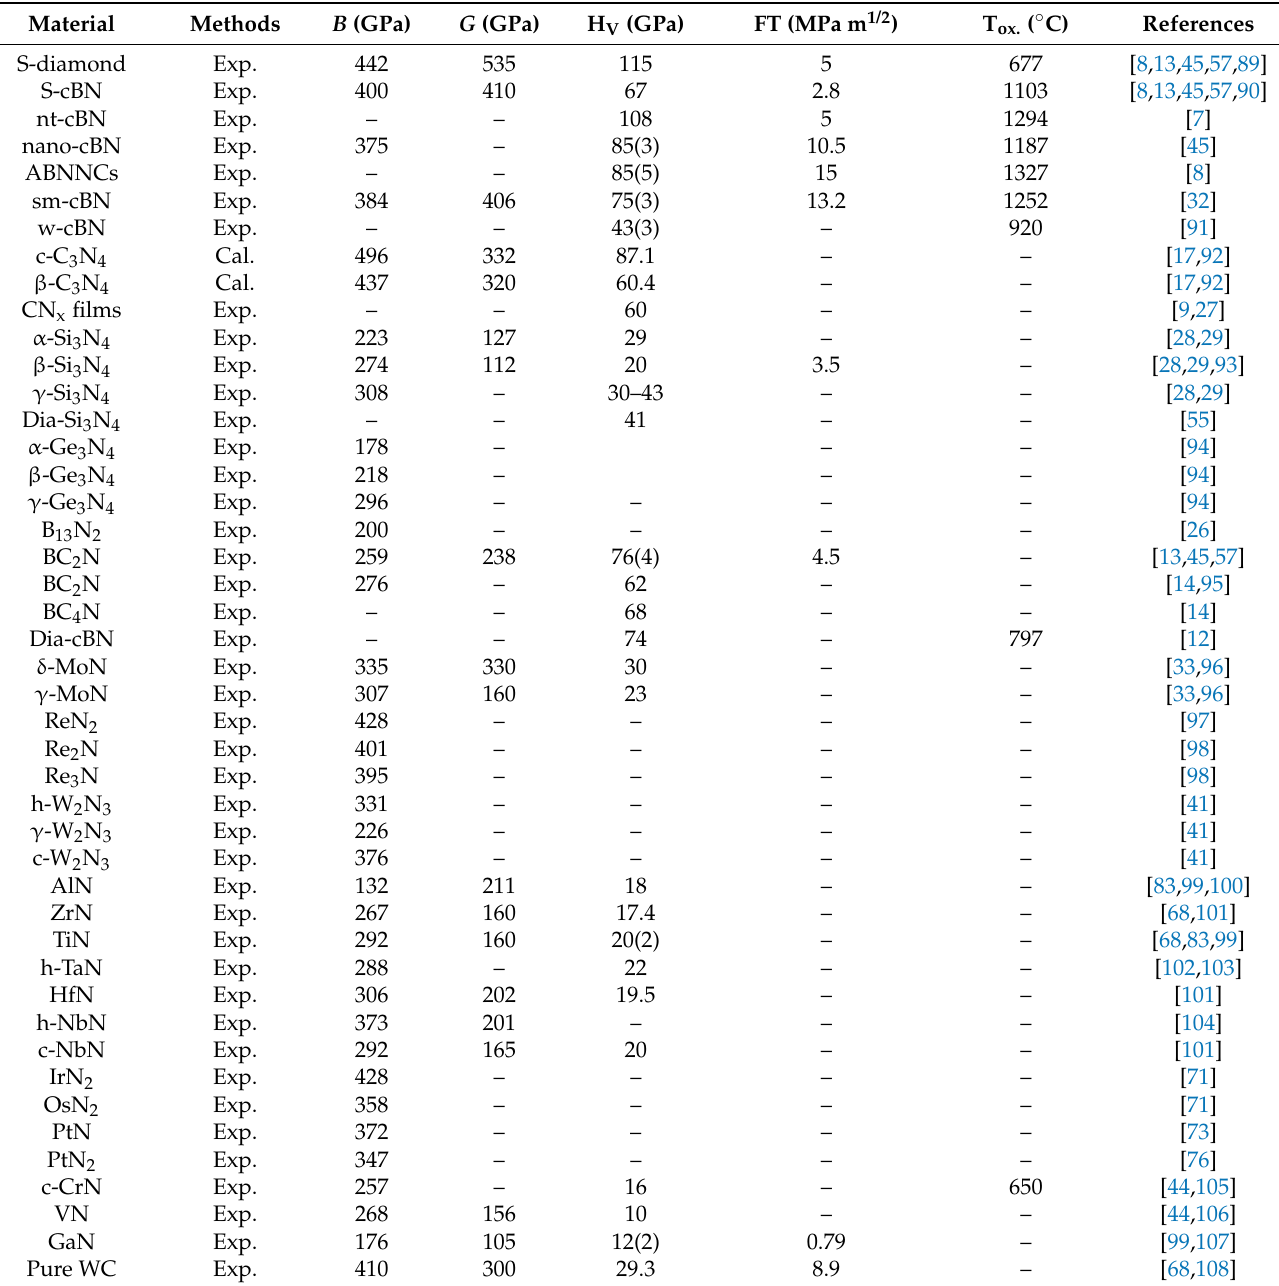
Table 1. Elastic properties, hardness, fracture toughness (FT), and thermal stability of diamond, tungsten carbide (WC), and hard or superhard nitride materials: bulk modulus B, shear modulus G, ABBNs (aggregated boron nitride nanocomposites), cubic (c) phase, hexagonal (h) phase, single-crystal diamond